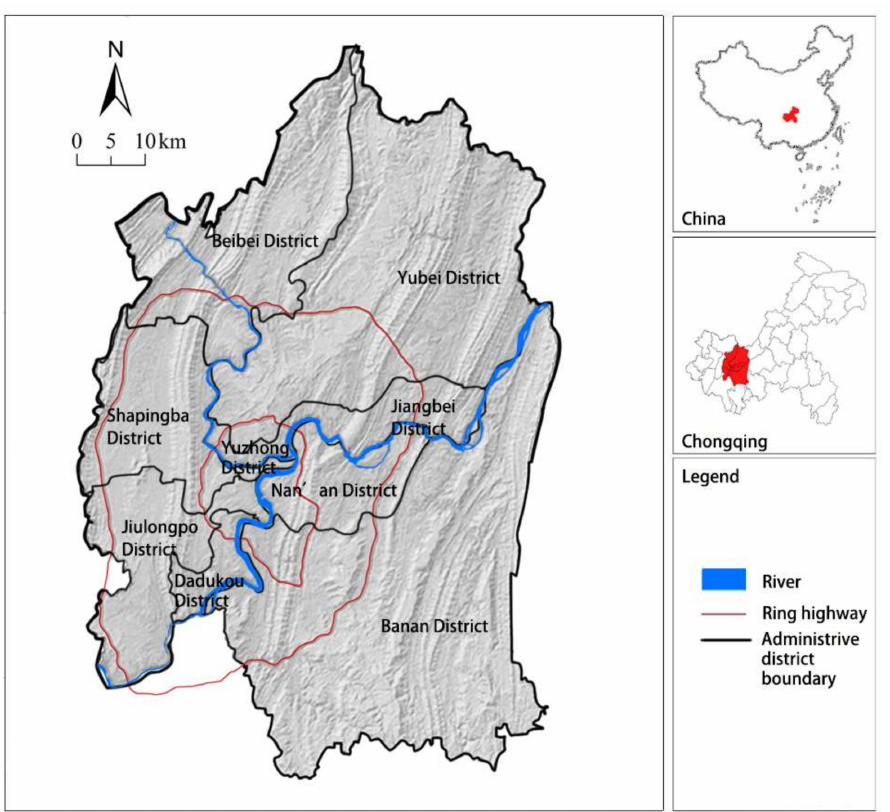
Figure 2. Study area and